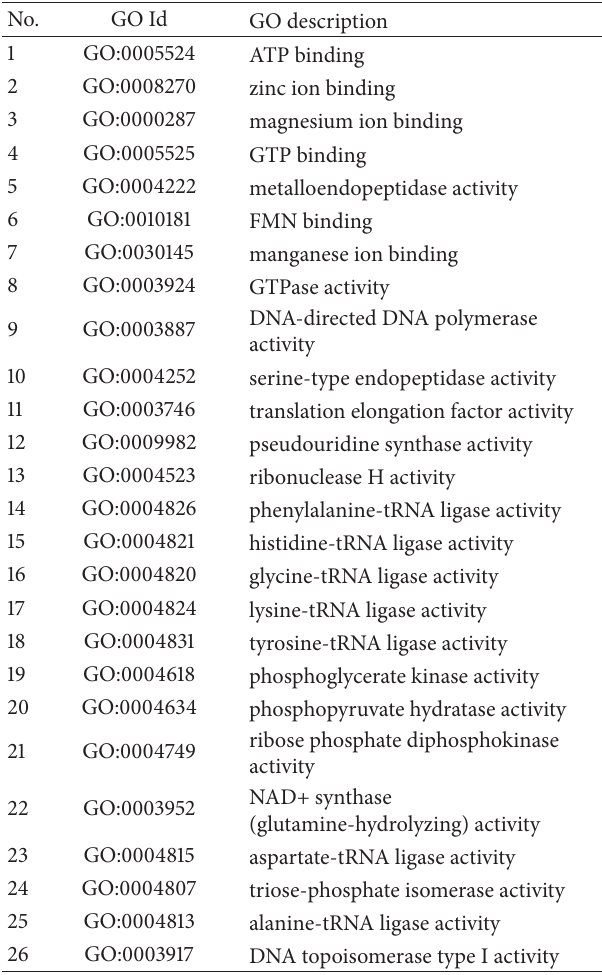
Table 2: List of universal GOs that were present in all functionomes of the function